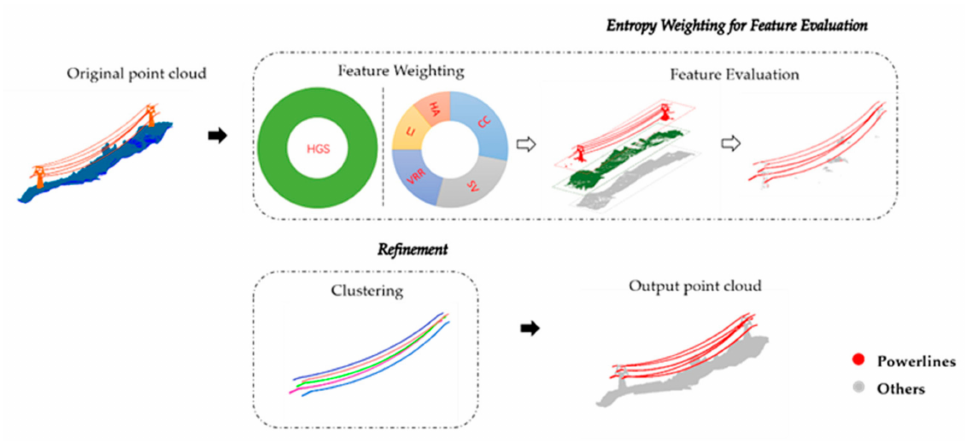
Figure 1. The workflow of the proposed EWFE